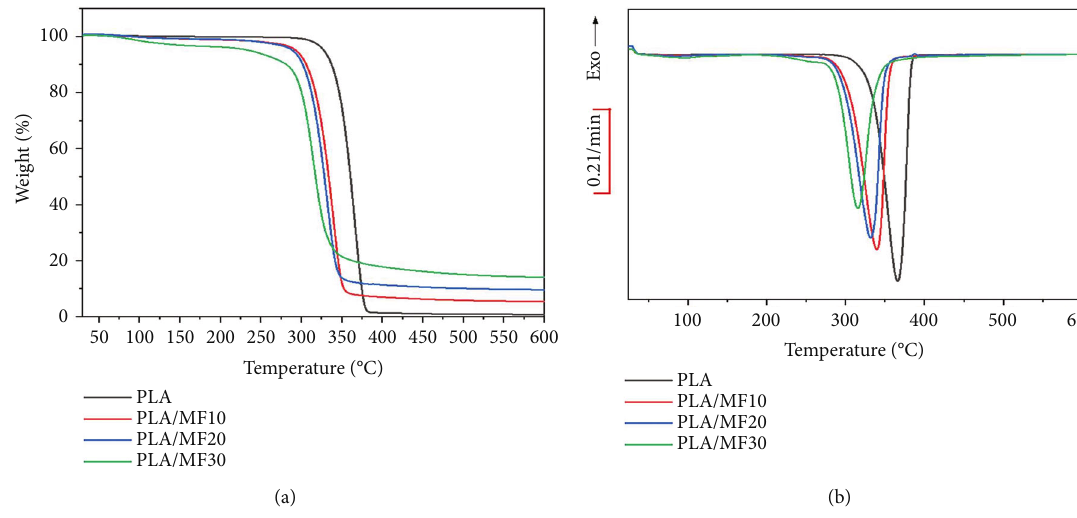
Figure 11: (a) TGA curve of PLA/MF composite. (b) DTG curve of PLA/MF composite. Table 6: Thermal degradation temperature of PLA/MF composites.